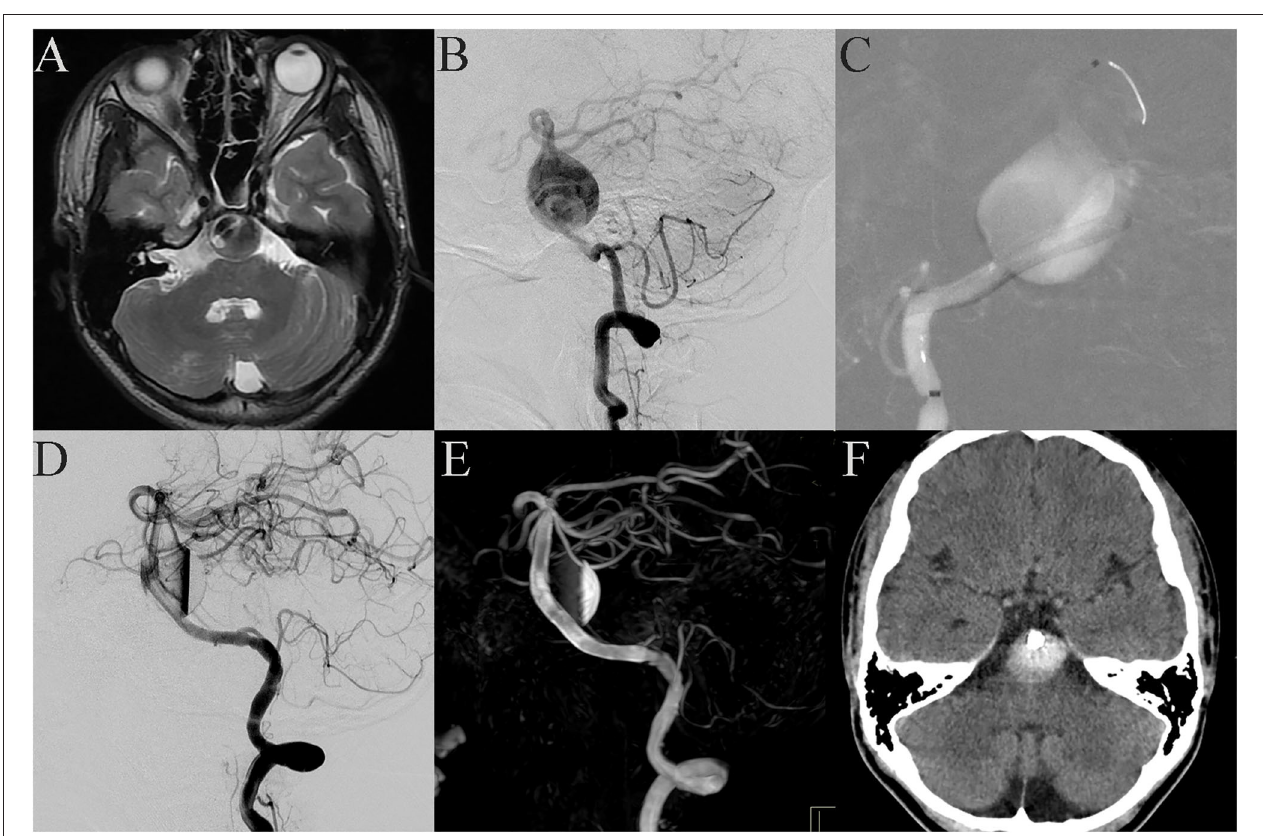
FIGURE 2 | Case 18: Basilar trunk containing a giant fusiform aneurysm ( A , MRI; B , lateral projection by DSA). During the stent bridging, the distal end of the stent easily fell into the aneurysm cavity (C) . Post-embolization angiograms showed contrast stasis (D) . Dyna CT showed good vascular reconstruction (E) . One day post-operation, the patient gradually presented dyspnea and hemiplegia. Emergent cerebral CT showed no obvious bleeding (F)